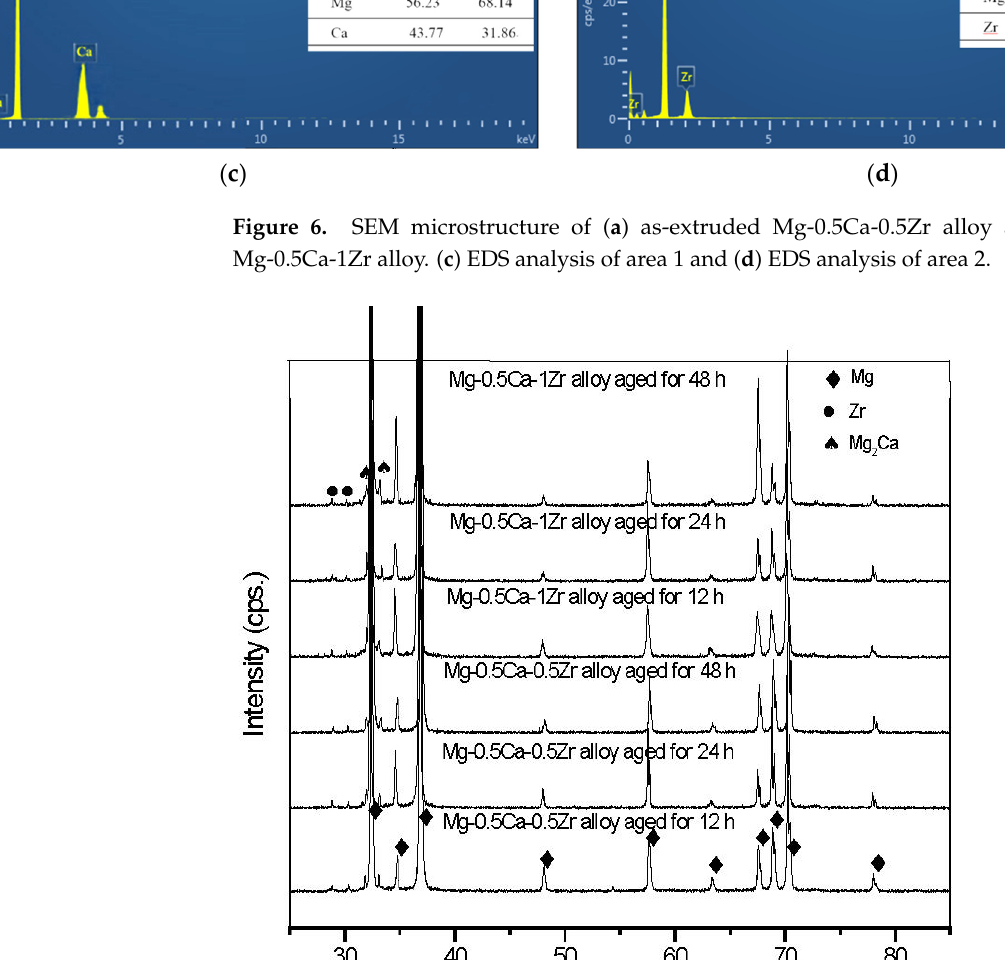
Figure 6. SEM microstructure of ( a ) as-extruded Mg-0.5Ca-0.5Zr alloy and ( b ) as-extruded Mg-0.5Ca-1Zr alloy. ( c ) EDS analysis of area 1 and ( d ) EDS analysis of area 2.